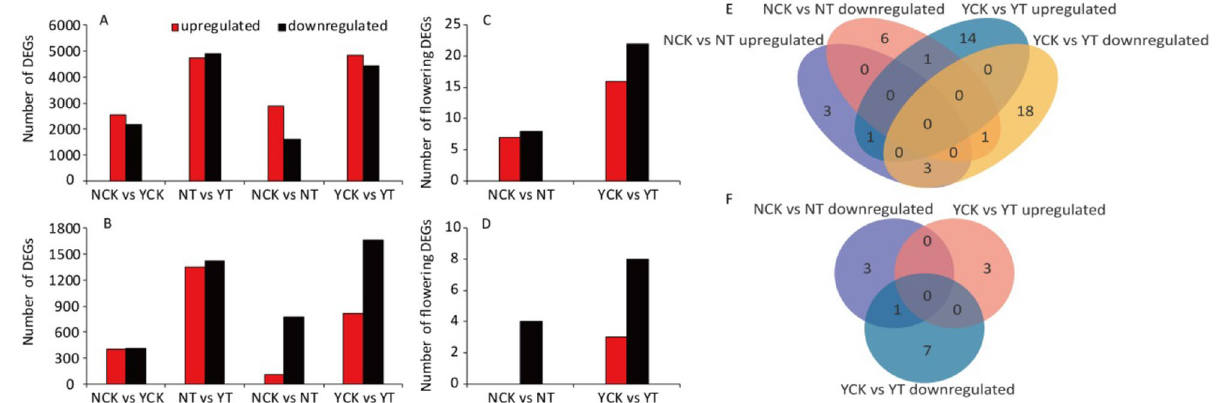
Figure 1. DEGs in the leaves ( A ) and panicles ( B ); flowering DEGs in the leaves ( C ) and panicles ( D ); and Venn diagrams of the DEGs in the leaves ( E ) and panicles ( F ) among the pairwise comparisons. This figure was created using Microsoft Excel 2010 and Adobe Illustraor